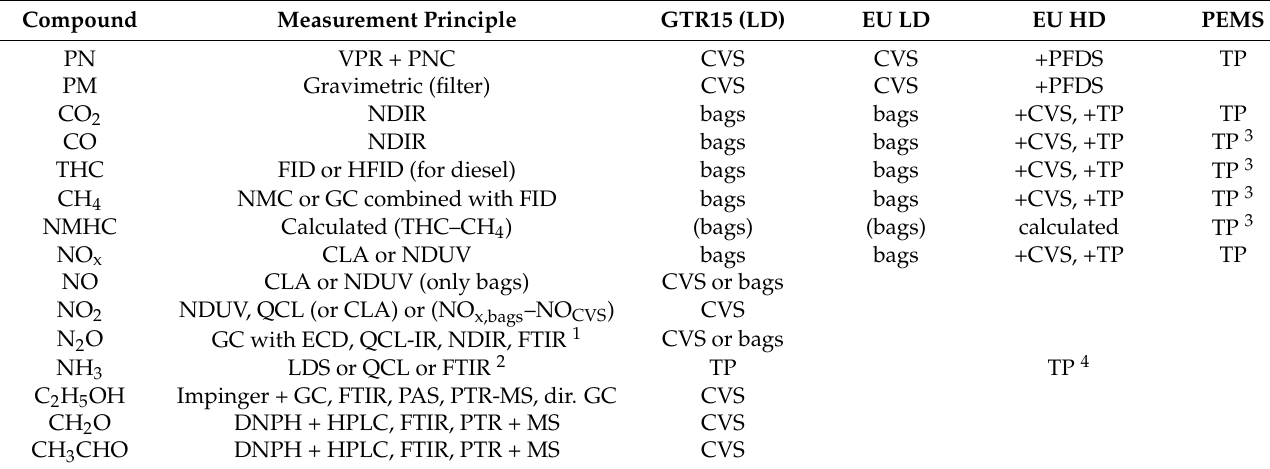
Table 1. Pollutants, principle of measurement, and the sampling option for light-duty (LD) vehicles and heavy-duty (HD) engines in the European Union (EU) regulation and the global technical regulation (GTR 15) for LD vehicles. PEMS (portable emissions measurement systems) refer to the EU regulation for both LD and HD vehicles. Measurements can be conducted directly from the dilution tunnel with constant volume sampling (CVS), the bags, the proportional partial flow dilution system (PFDS), or the tailpipe (TP), depending on the